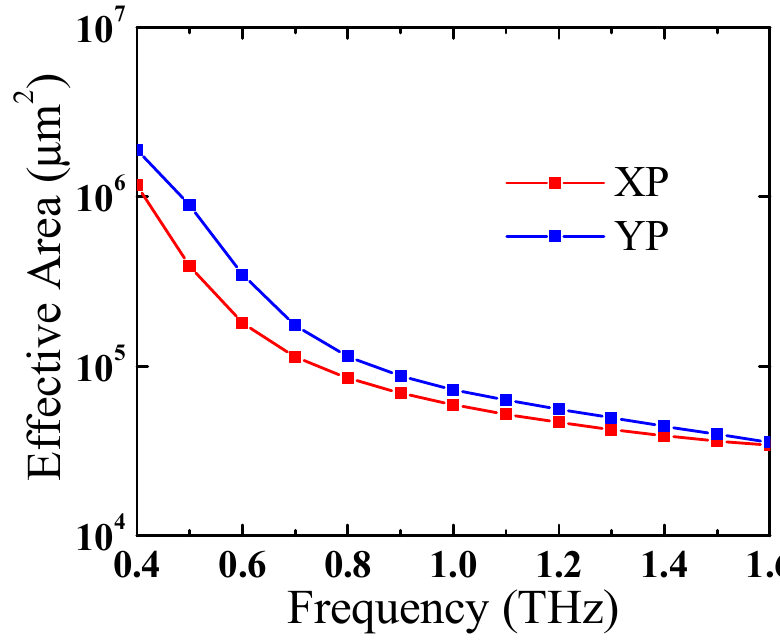
Figure 9. Response of e ff ective area and bending loss to frequency for the QE XP and YP modes.